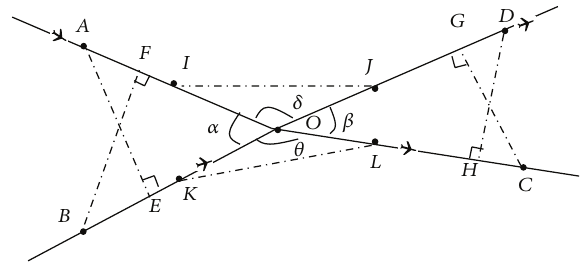
Figure 4: Type I horizontal crossing protection